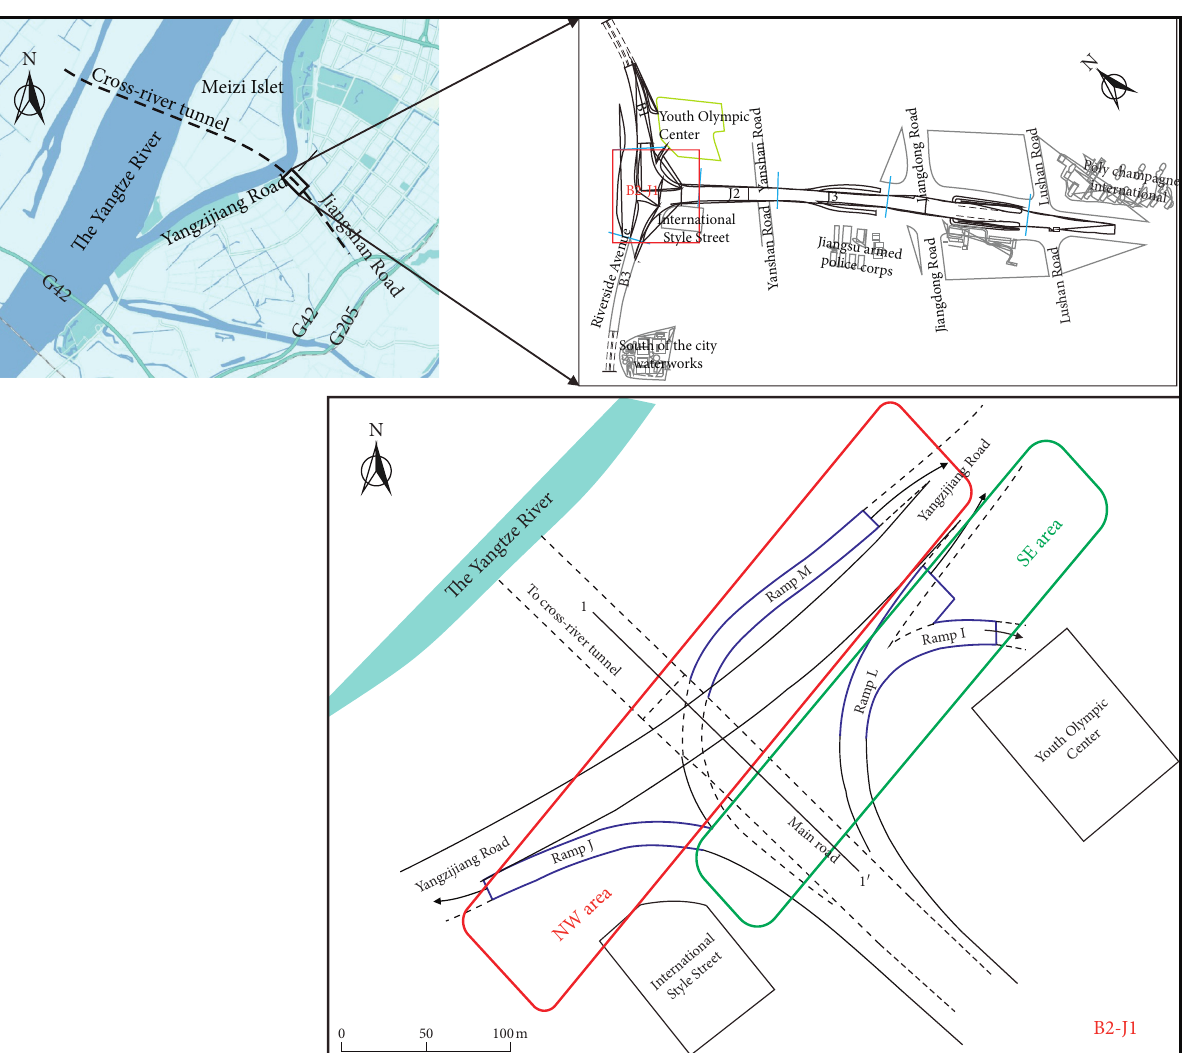
Figure 1: Location and plane layout of the foundation pit of